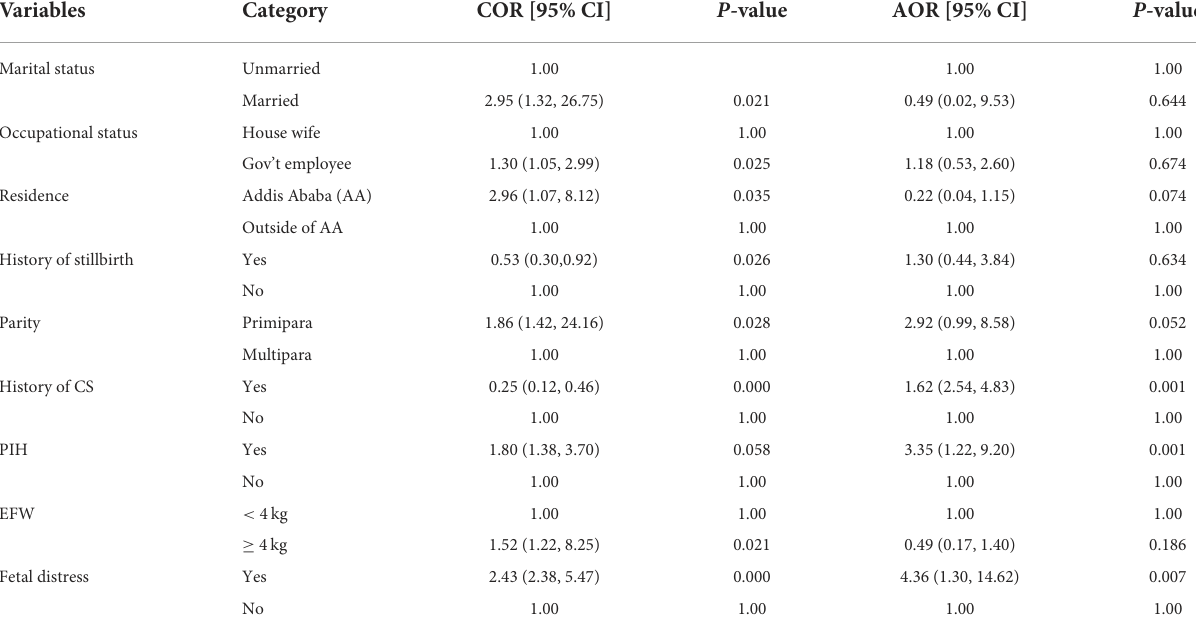
TABLE 4 Factors associated with cesarean-section among diabetic mothers delivered at the Tikur Ambessa Specialized Hospital in Addis Ababa, Ethiopia, 2018. Variables Category COR [95%